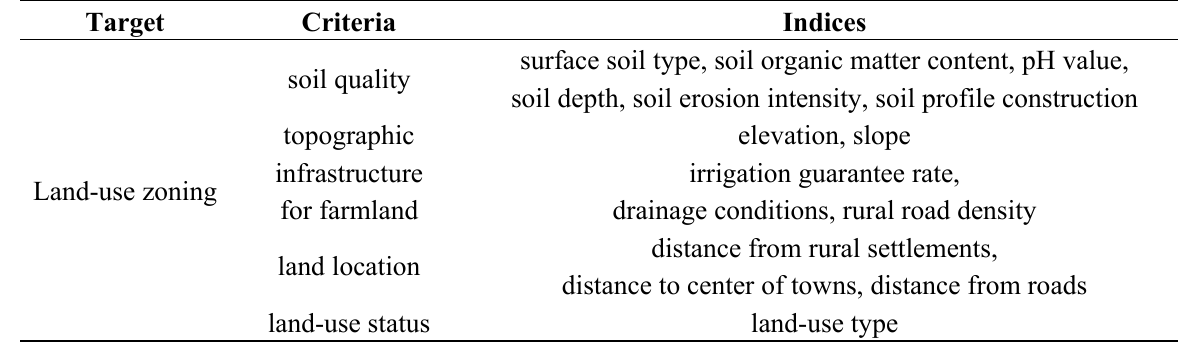
Table 1. Land-use zoning